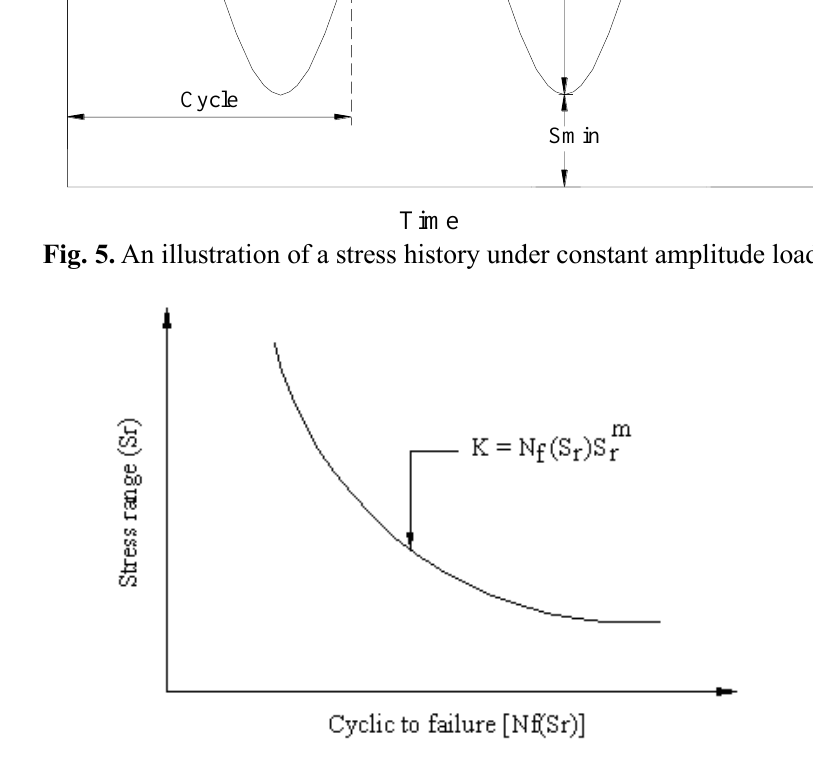
Fig. 6. A typical S-N curve for outcomes of constant amplitude